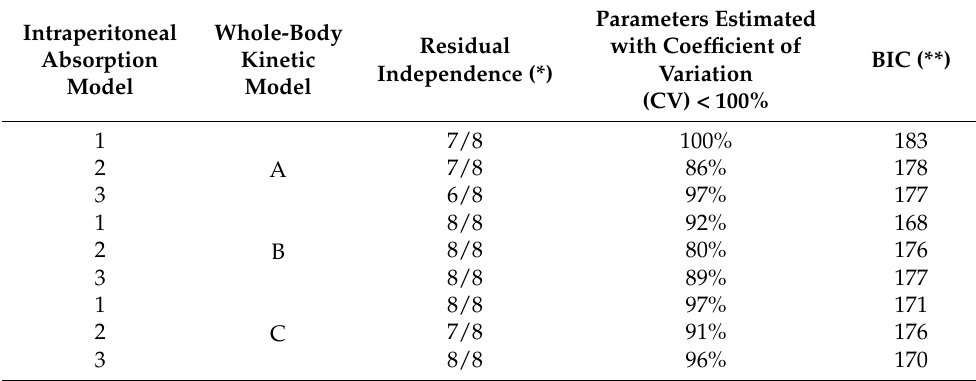
Table 1. Summary results of model